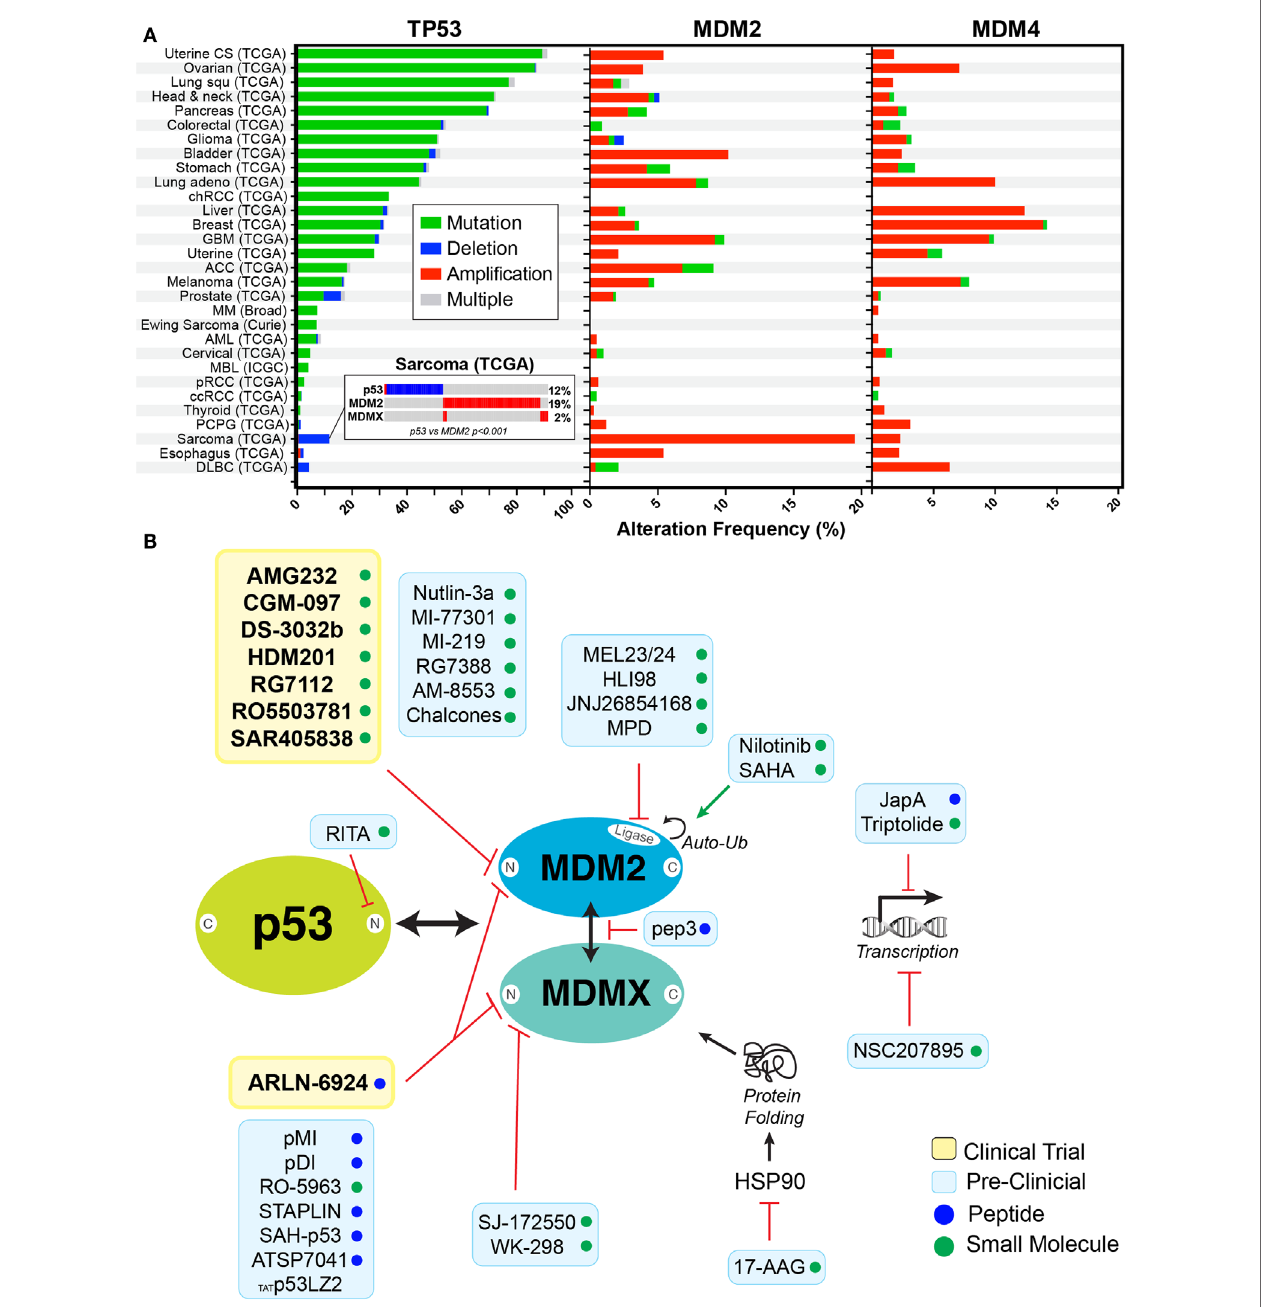
FiGURe 1 | Rationale for targeting p53 in cancers. (A) Frequency of alterations are shown with mutation (green), deletion (blue), amplification (red), and combination of alterations (gray) in p53, MDM2, and MDMX in cancers derived from cBioPortal (5) (http://www.cbioportal.org). Insert shows the mutual exclusivity observed between MDM2 expression and p53 deletion in sarcomas. (B) Schematic representation of inhibitors in clinical trials (yellow box) or in preclinical studies (blue box) targeting the p53–MDM2/X axis. Compounds are either small molecules (green circle) or peptide (blue